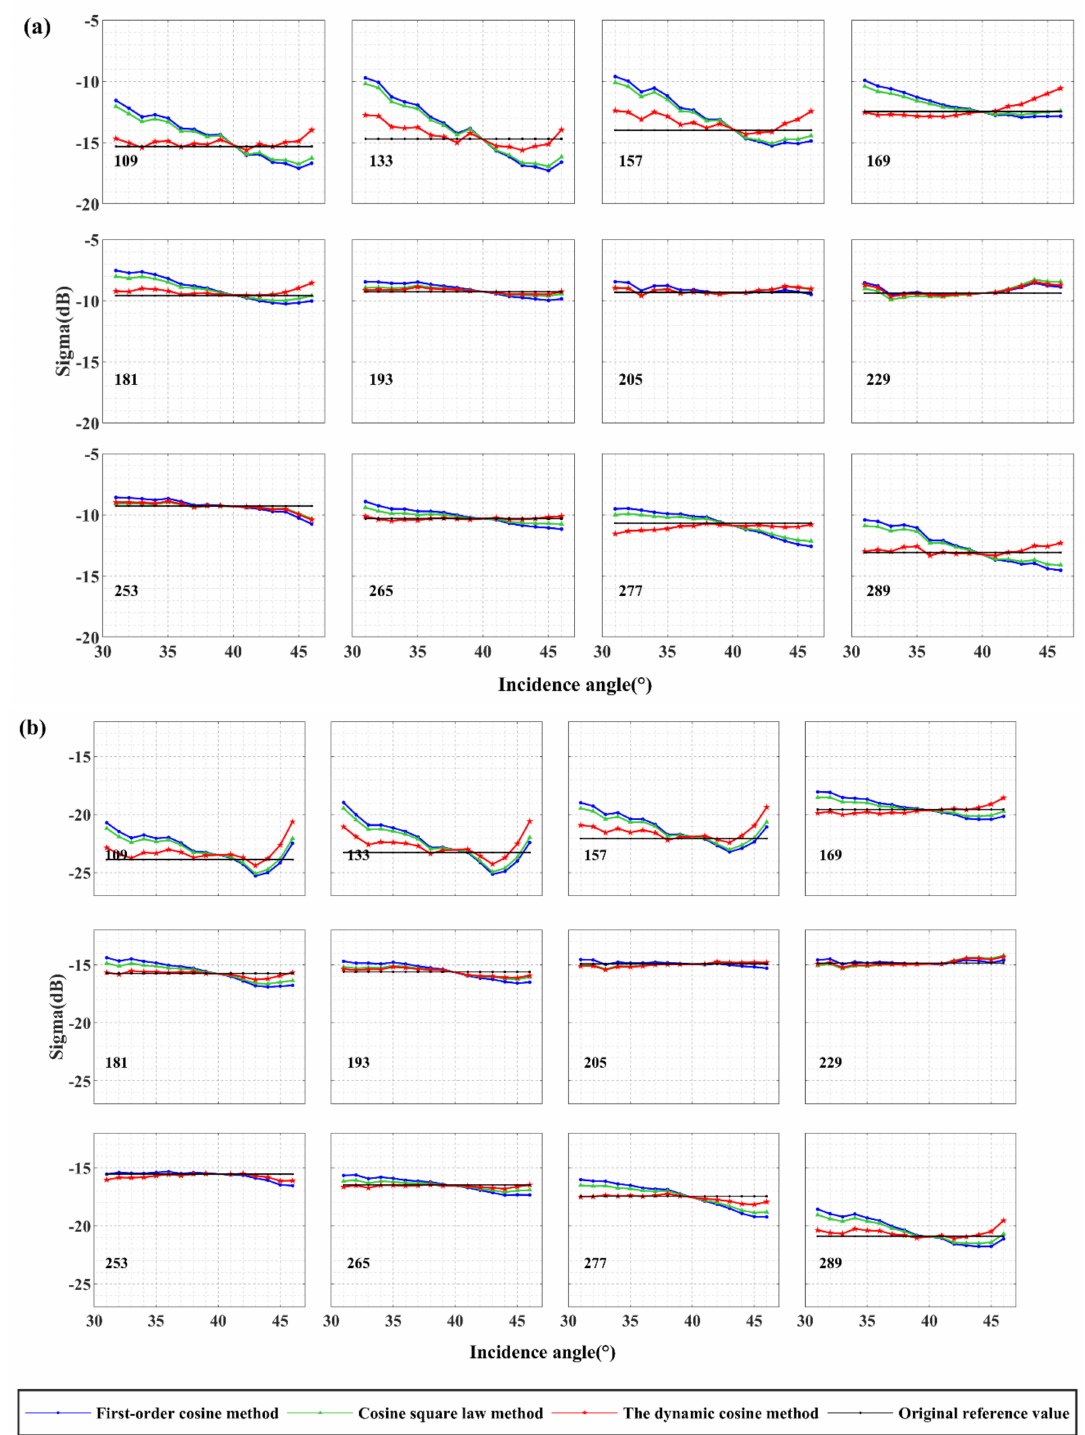
Figure 9. The comparison of σ 0 and σ 0 norm normalized to 40 ◦ by first-order cosine normalization, cosine square law obs normalization, and dynamic cosine method from April to October. ( a ) VV polarization; ( b ) VH